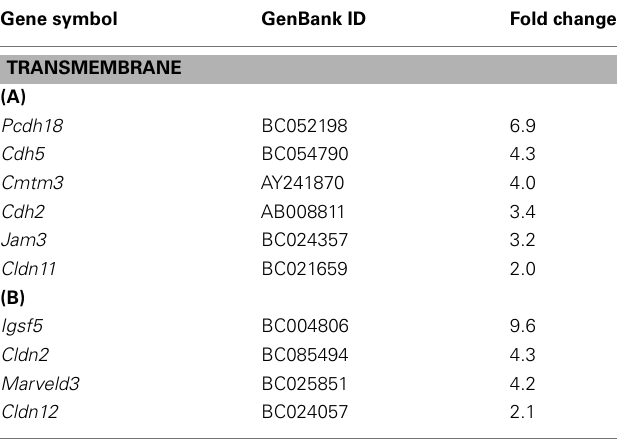
Table 1 |Tight junction protein genes enriched in mouse lateral ventricular choroid plexus.